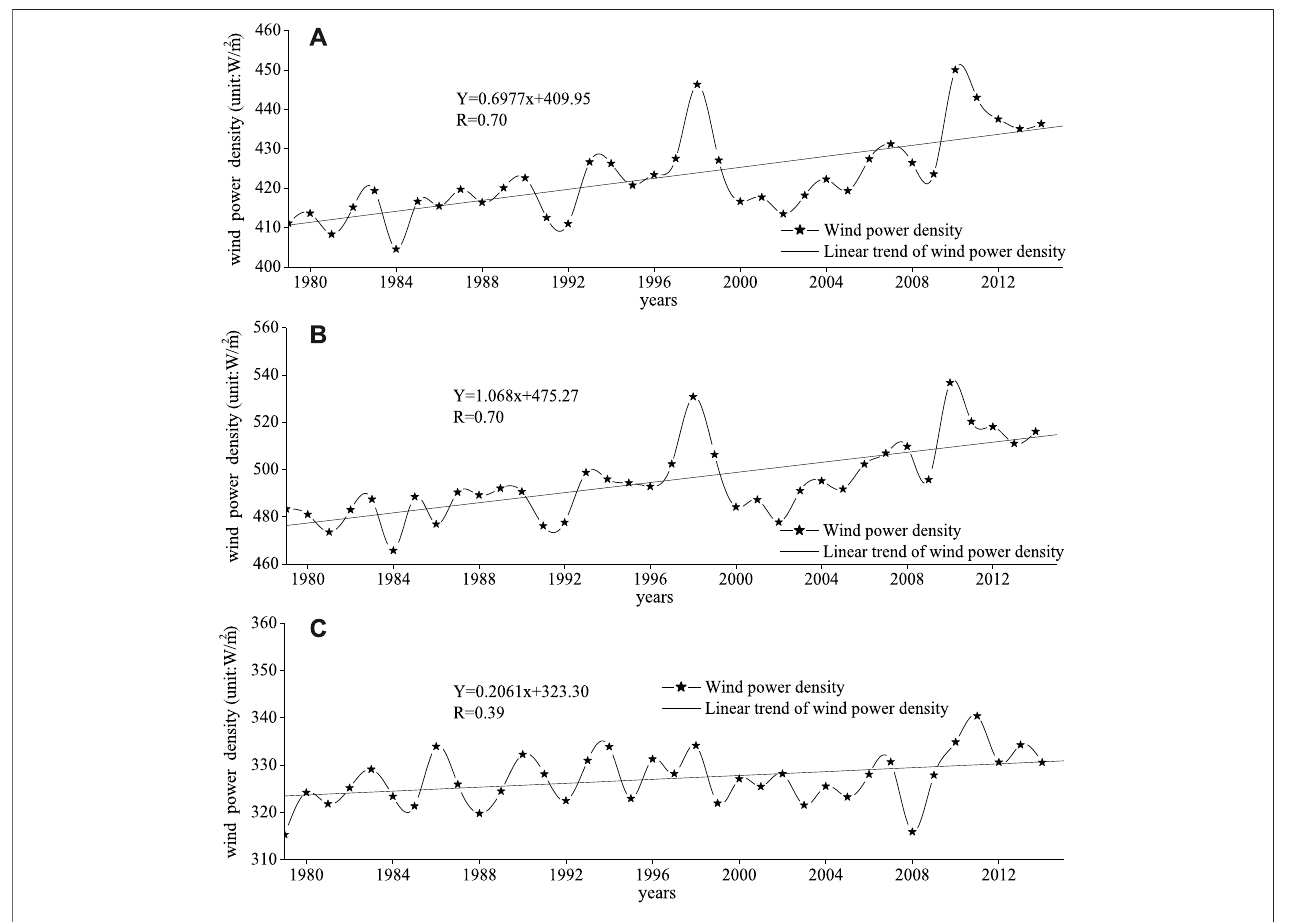
FIGURE 2 | Annual average wind power density in the global ocean (A) , south global ocean (B) , and the north global ocean (C) for the period 1979 – 2014 and the long-term trends.